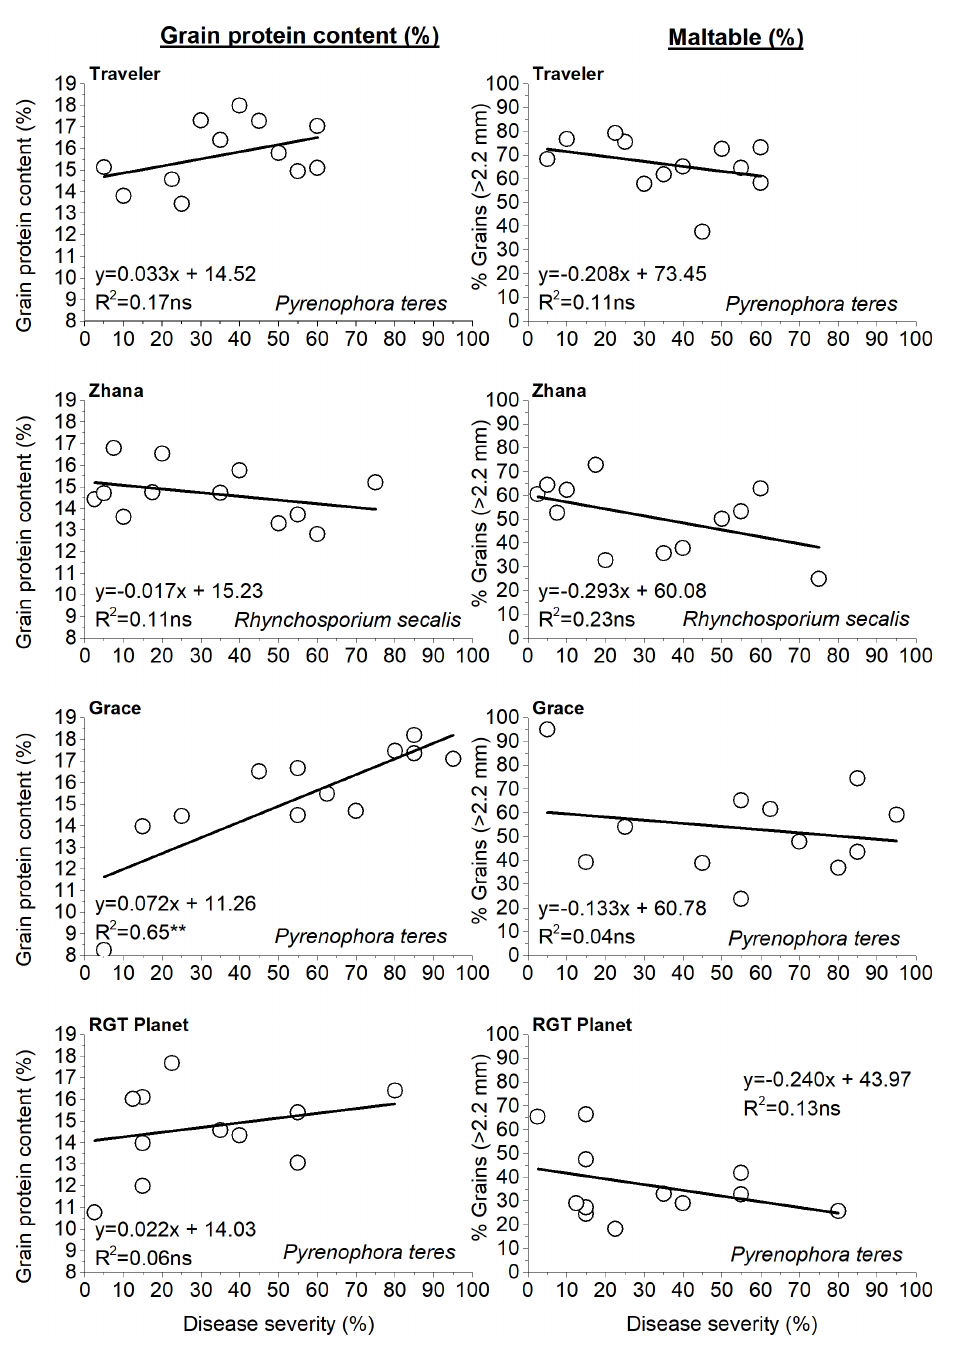
Figure 8. Relationship of disease severity (caused by Pyrenophora teres f. teres and Rhynchosporium secalis ) with grain protein content and maltable grain size fraction (>2.2 mm) at grain filling phase when the main source of variation is the nitrogen rate. ** At P ≤ 0.01; ns = non-significant.